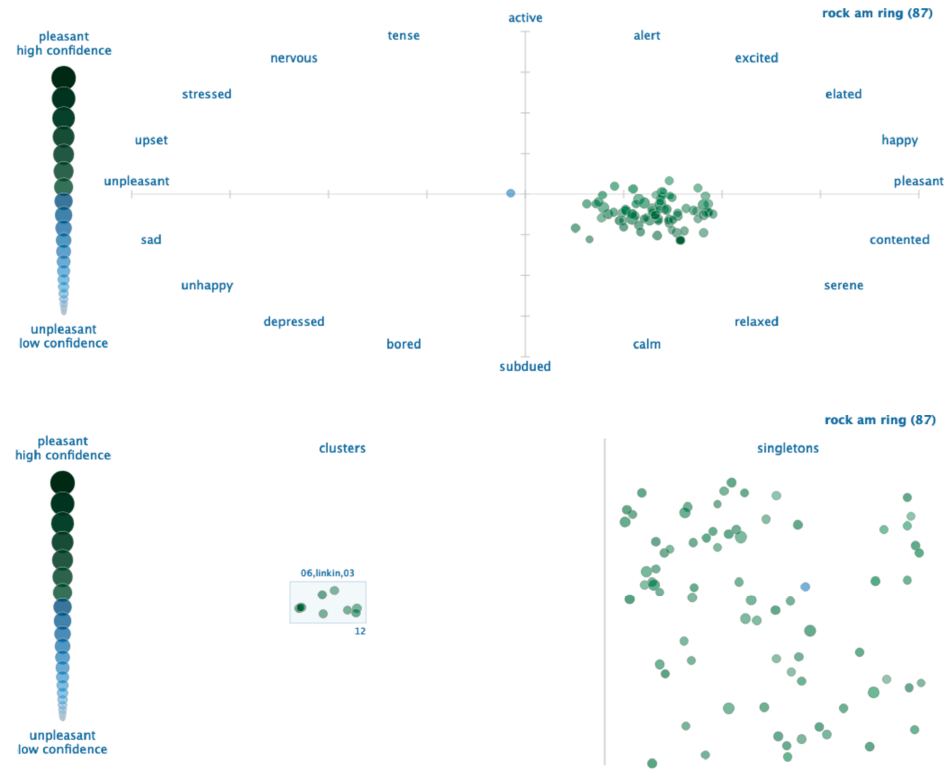
Figure 2. Looking into the data for persona construction: sentiment ( top ) and topics ( bottom ). The users select and view the sentiment for the entities of interest and the cluster information for a deeper view of how topics are semantically identified. Big Data Cogn. Comput. 2020 , 4 , x FOR PEER REVIEW